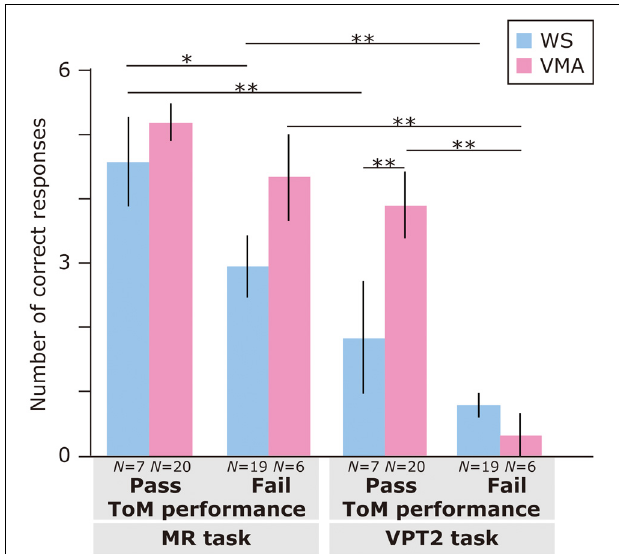
FIGURE 3 | Mean number of correct trials (max: 6) in the MR and VPT2 tasks based on ToM task performance of two groups [blue: Williams syndrome (WS) group; pink: verbal mental age-matched (VMA) group]. ∗∗ p < 0 . 01; ∗ p < 0 . 05.